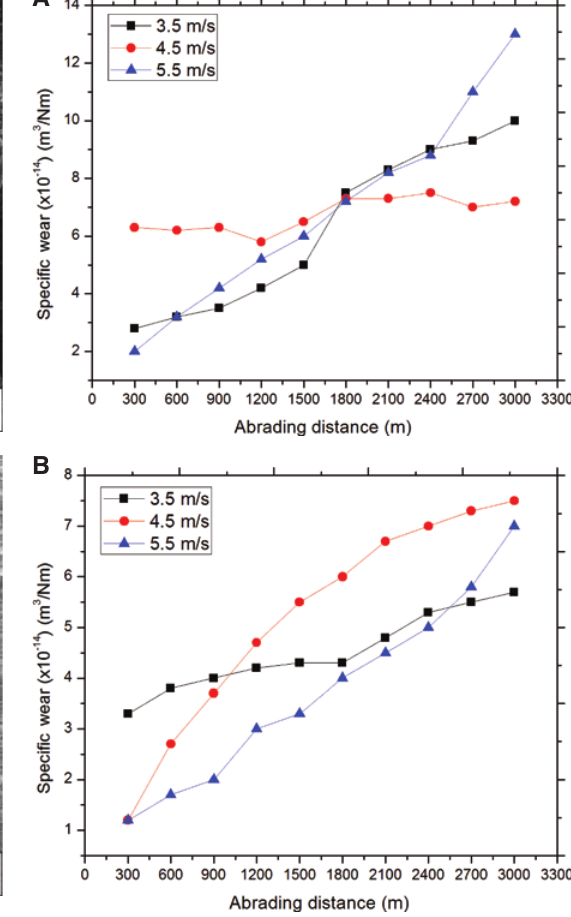
Figure 7 Worn surface morphology, run at 3.5 m s -1 with 10 N load: untreated composites (A) and alkali-treated composites (B).